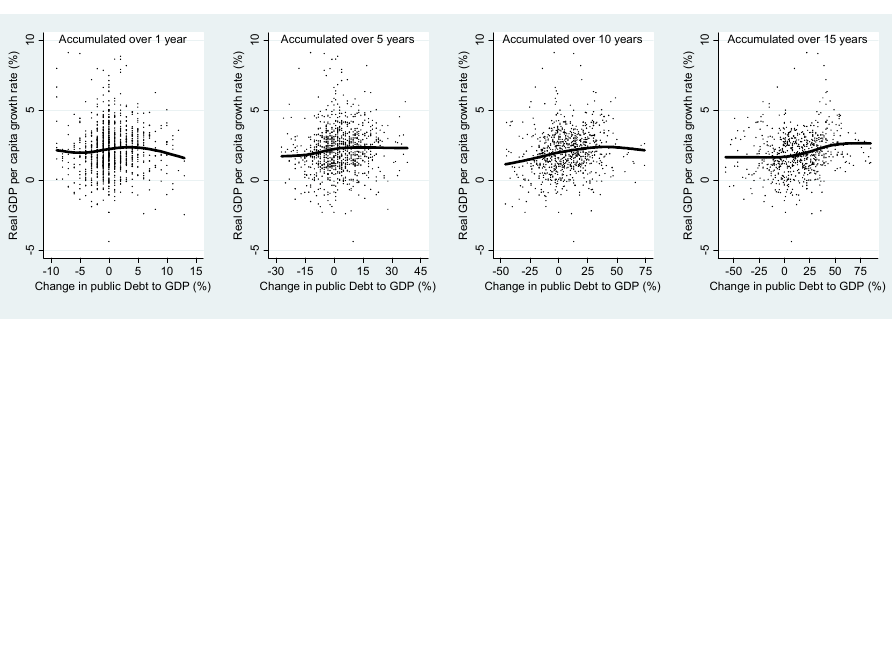
Figure 13 - Growth performance over 5 years with debt accumulation over 1-15 year (h=1 and d=1,5,10,15) – Public & private